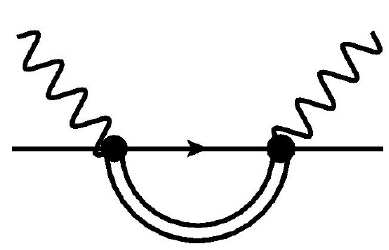
Figure 8 . We show the only diagram that contributes to (cid:12) (cid:26) Other diagrams with internal metric (cid:13)uctuations and the correct number of external legs vanish when projected onto (cid:26) 4 according to eq.